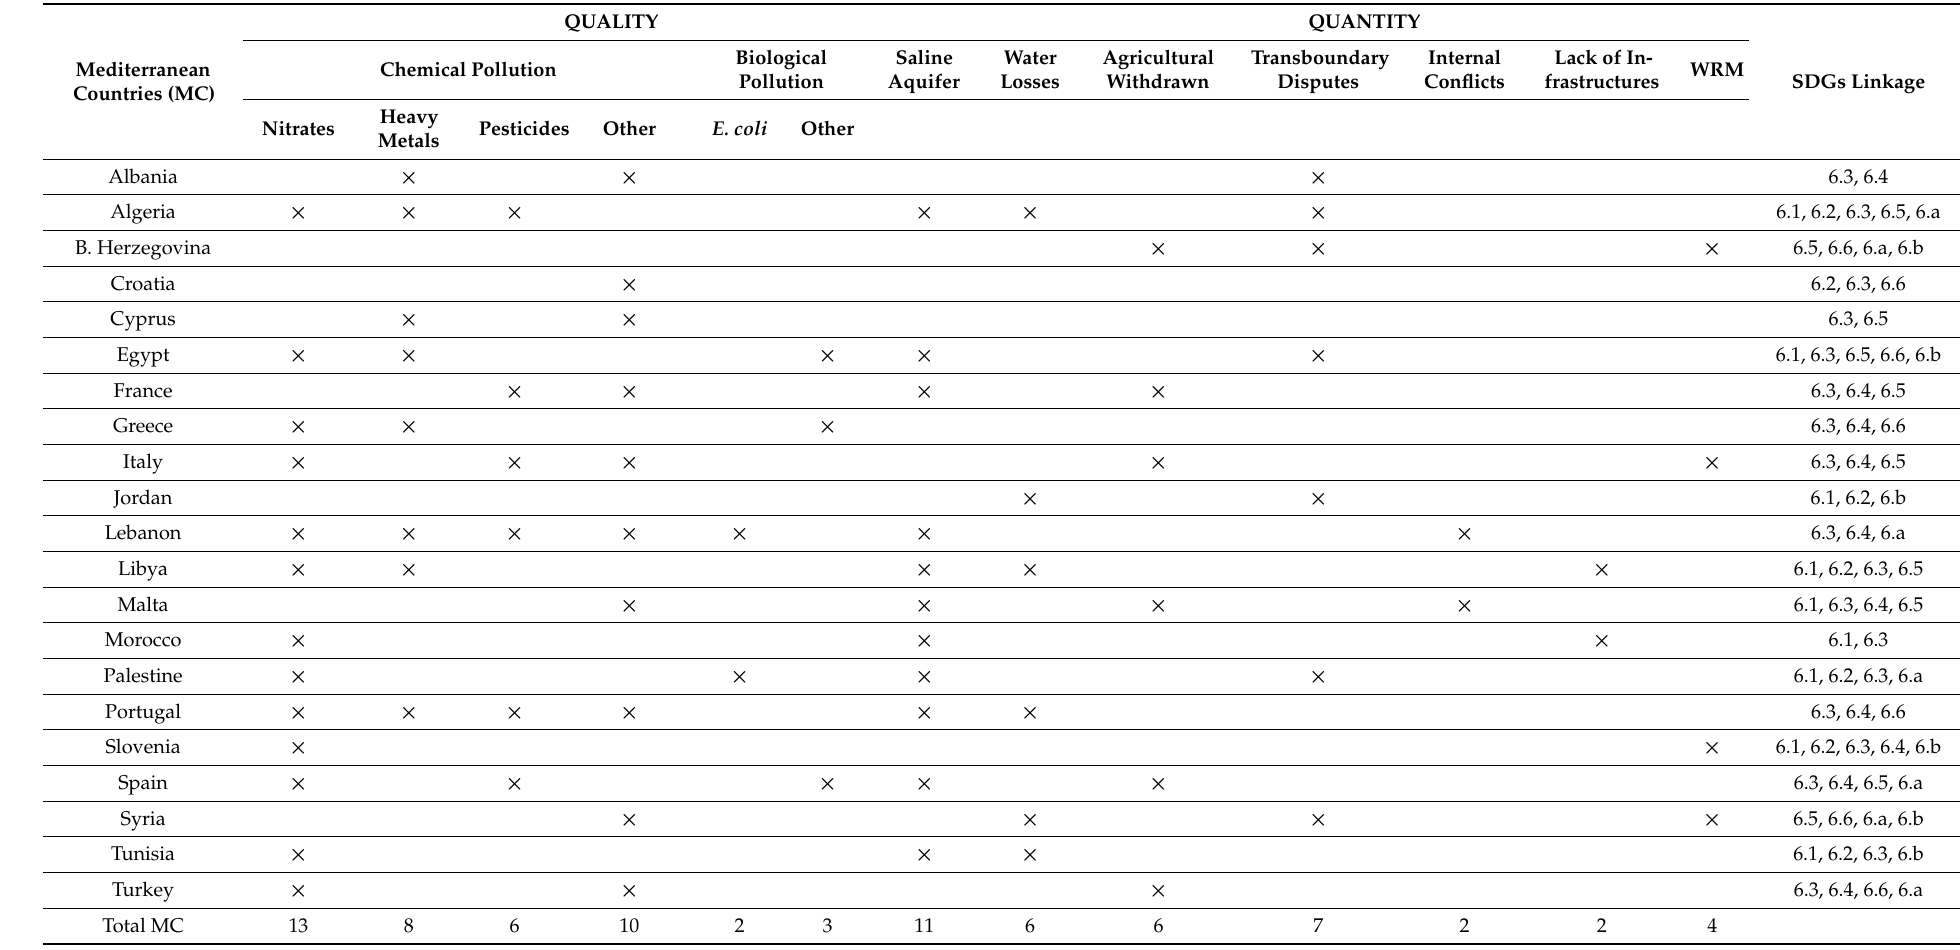
Table 4. Main water challenges facing Mediterranean